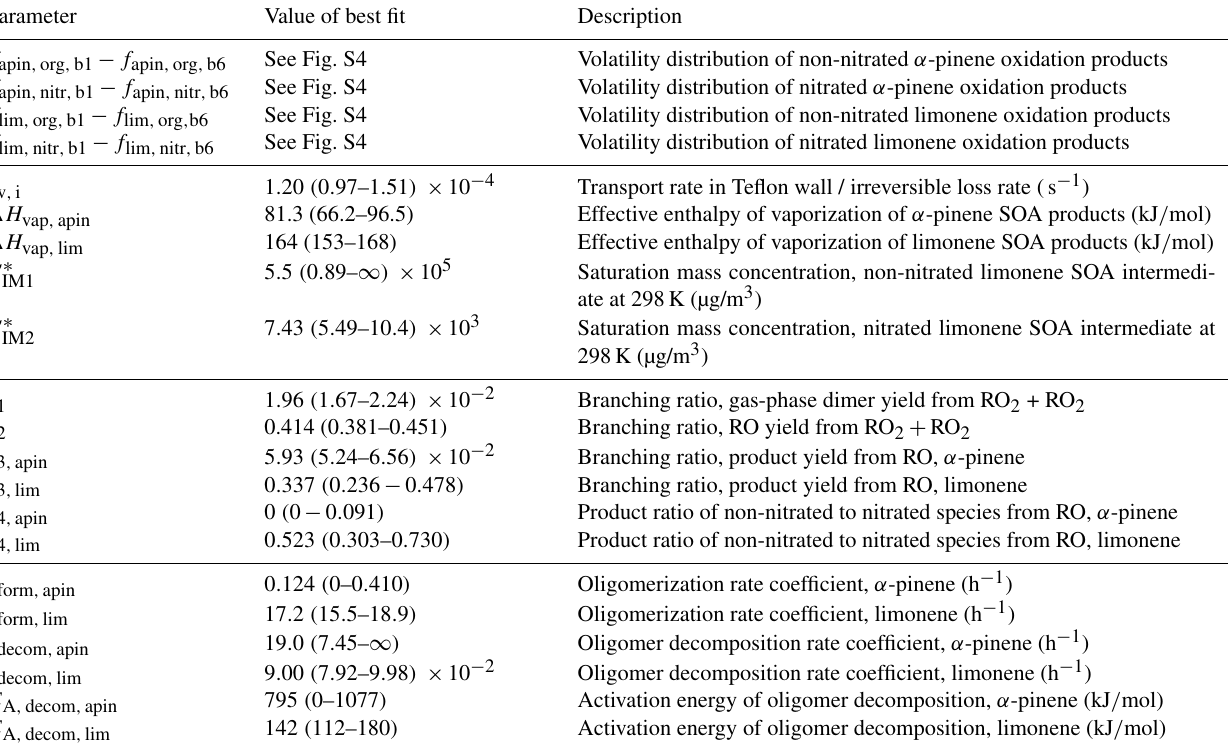
Table 1. Fit parameters of the kinetic model. Error estimates for the volatility distribution (parameters f apin and f lim ) can be found in Fig. S4 in the Supplement; error estimates for all other parameters are ranges in which a parameter can be varied until the model–experiment correlation decreases by 10 %. For a full list of kinetic parameters, see Table S1.